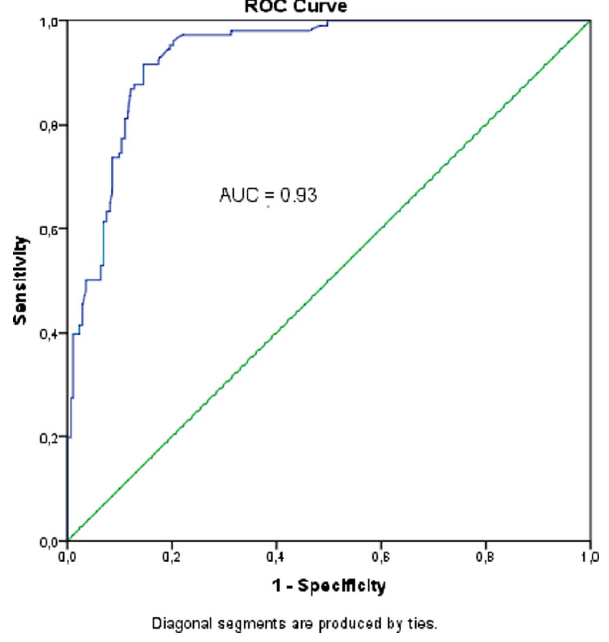
Figure 1. Receiver Operator Characteristic (ROC) decision plot. ROC curve analysis obtained by using the real-time PCR Ct values (universal probe) versus urine culture results (Cut-off value of $ 10 5 CFU/ml).